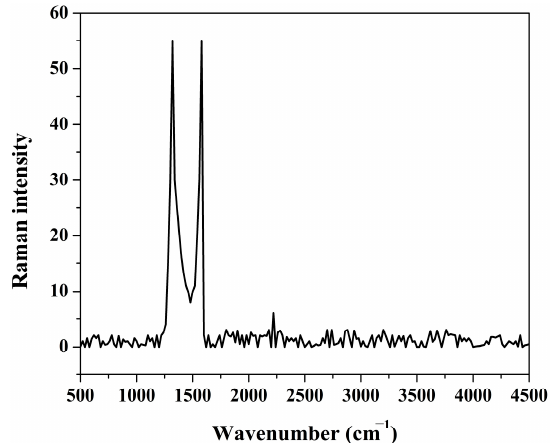
Figure 5. Raman spectroscopy spectrum for the prepared powder produced from hydrothermal treatment using 1.0 M KOH at 170 °C for 3 h and calcined at 600 °C.